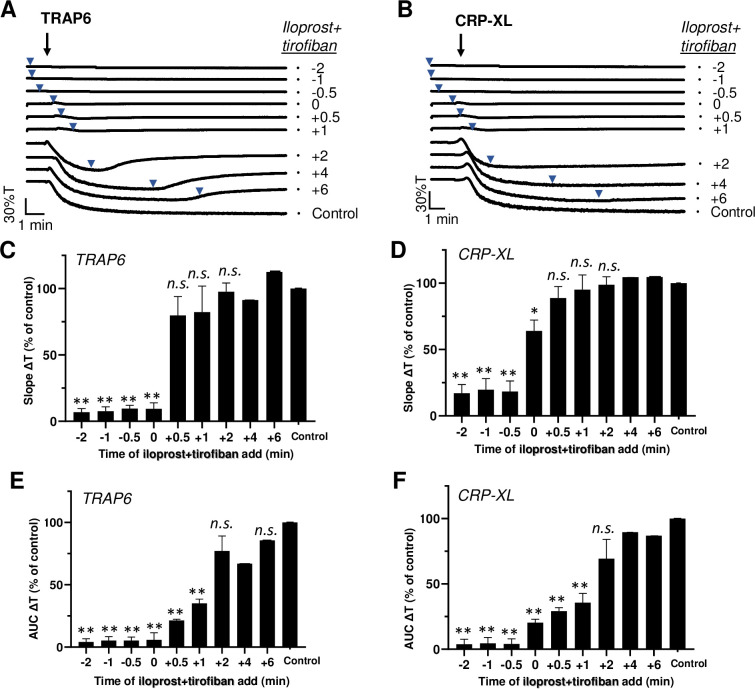
Post-hoc inhibitory effect of iloprost plus tirofiban on agonist-induced platelet aggregation.Platelets in suspension were stimulated with 10 μM TRAP6 (A-C) or 5 μg/mL CRP-XL (D-F), and aggregation was recorded by light transmission aggregometry. Iloprost (10 nM) in combination with tirofiban (1 μg/mL) was added before (-2, -1 or -0.5 min), simultaneously with (0 min) or after (+0.5, +1, +2, +4, +6 min) the indicated agonist. See Fig 1. Means ± SEM (n = 3). *P<0.05, **P<0.001 vs. control traces, paired Student t-test.